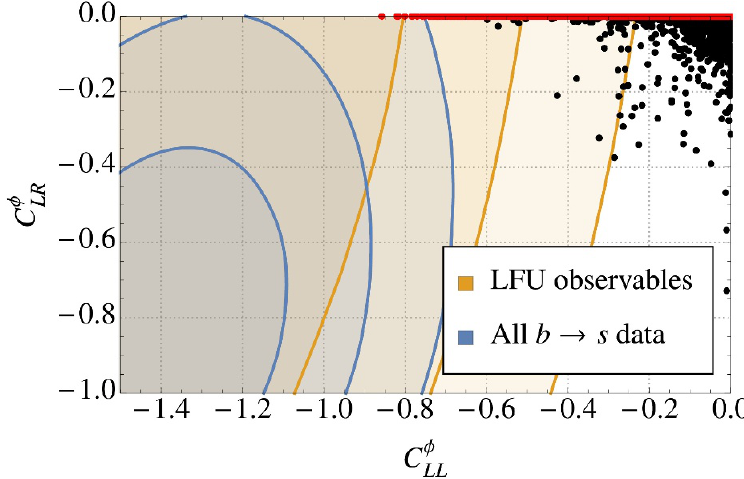
(a) The results of scan I (black) and scan II (red) projected onto the C (cid:30) { C (cid:30) plane. The colored LL LR contours correspond to those in (cid:12)gure 4: the orange represent the (cid:12)t to only LFU observables while the blue take into account all b ! s observables. The model can alleviate the tensions in LFU observables to just within the 1 (cid:27) region, a signi(cid:12)cant improvement on the SM. In this region, (cid:25) 0, implying a suppression of the y 2 . Agreement with all of the b ! s data is not as good. C (cid:30) i LR